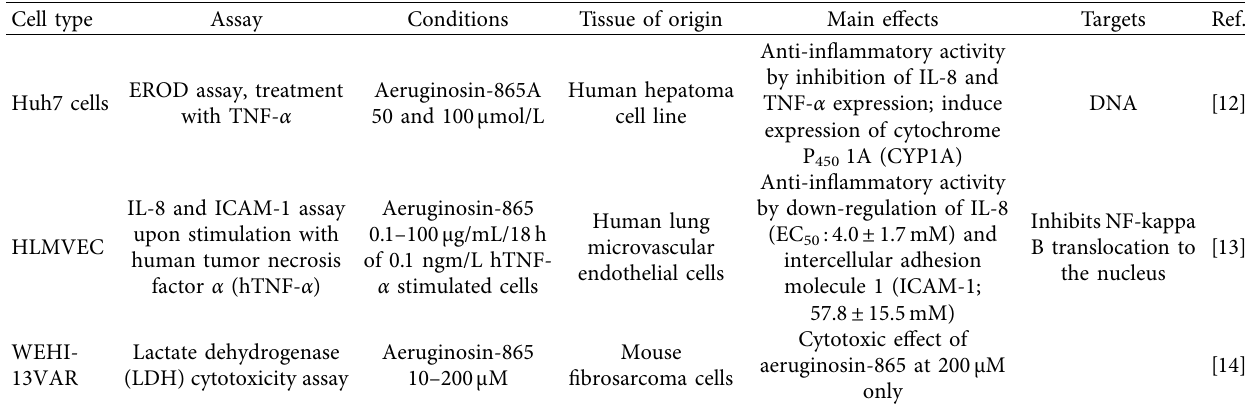
Table 1: Cytotoxicity of aeruginosins.